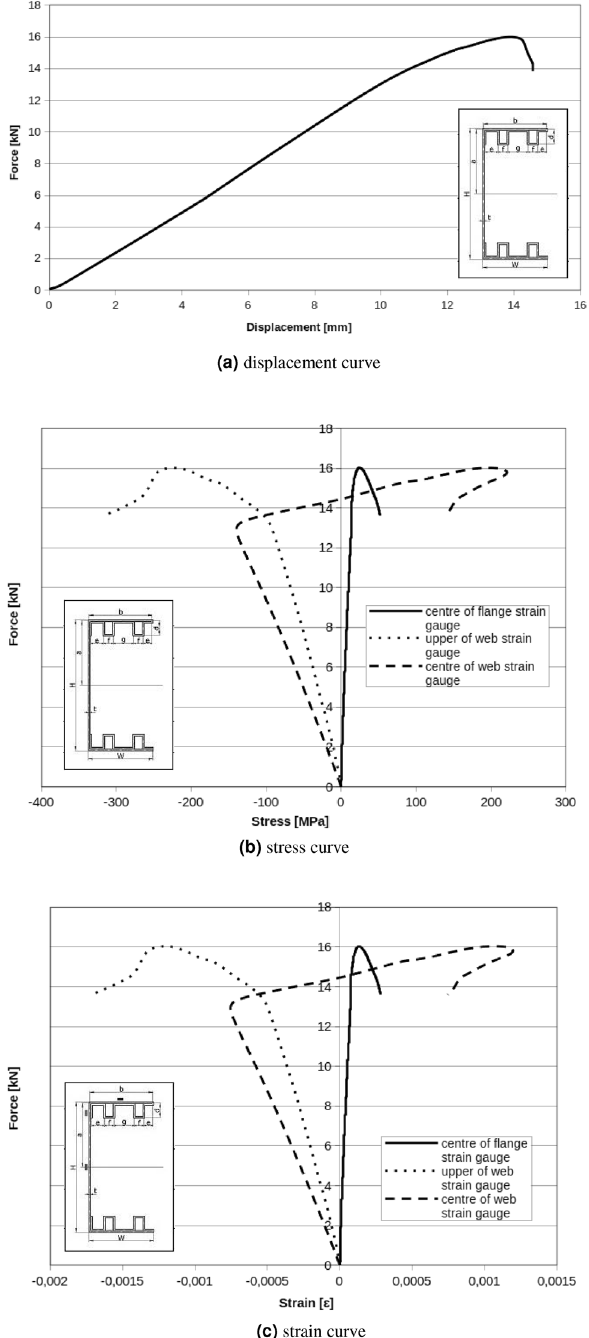
Figure 12. Double box flanges and reinforcement